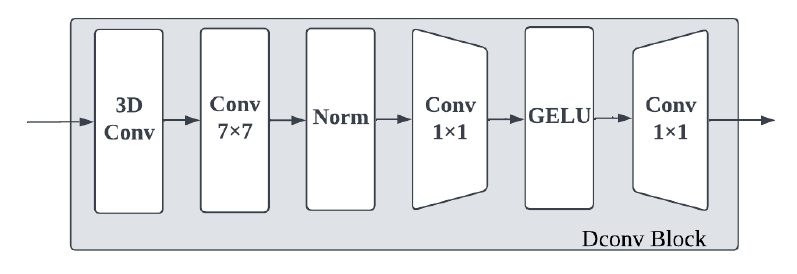
Figure 3. Patch merging process